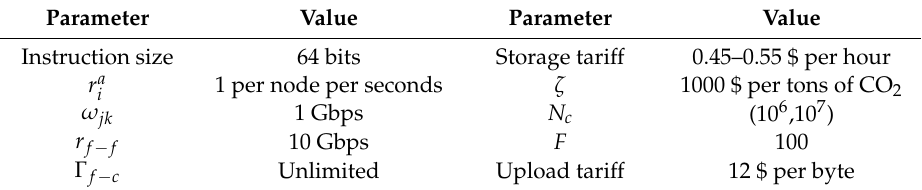
Table 1. Simulation